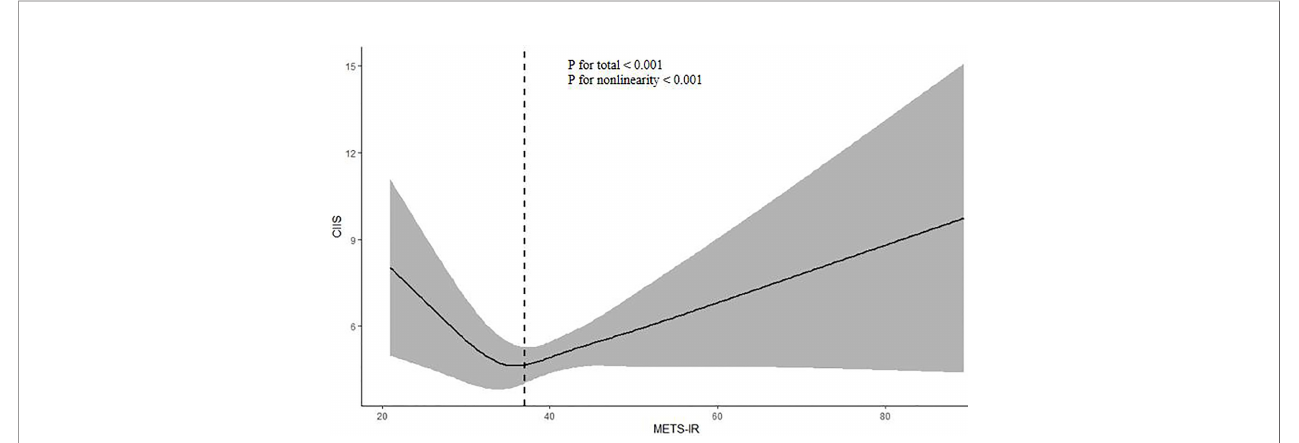
FIGURE 2 | Restricted cubic spline plot of the association between METS-IR and CIIS. The association was adjusted for variables included in Model 4. METS-IR metabolic score for insulin resistance, CIIS cardiac infarction/injury